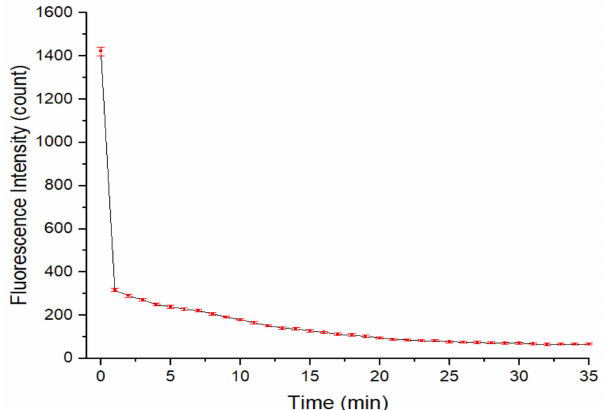
Figure 7. Relationship between the fluorescence intensity of the QD solution and the time after addition of the APDC solution. Concentration of Tris-HCl bu ff er solution: 10 mmol / L. pH of Tris-HCl bu ff er solution: 8.5. Concentration of added QD solution: 5 µ mol / L. Concentration of APDC solution: 100 µ mol / L. Addition order: Tris-HCl bu ff er solution (2 mL) → QD solution (0.4 mL) → APDC solution (0.52 mL) → Tris-HCl bu ff er solution (1.08 mL). Excitation wavelength: 460 nm. Observation